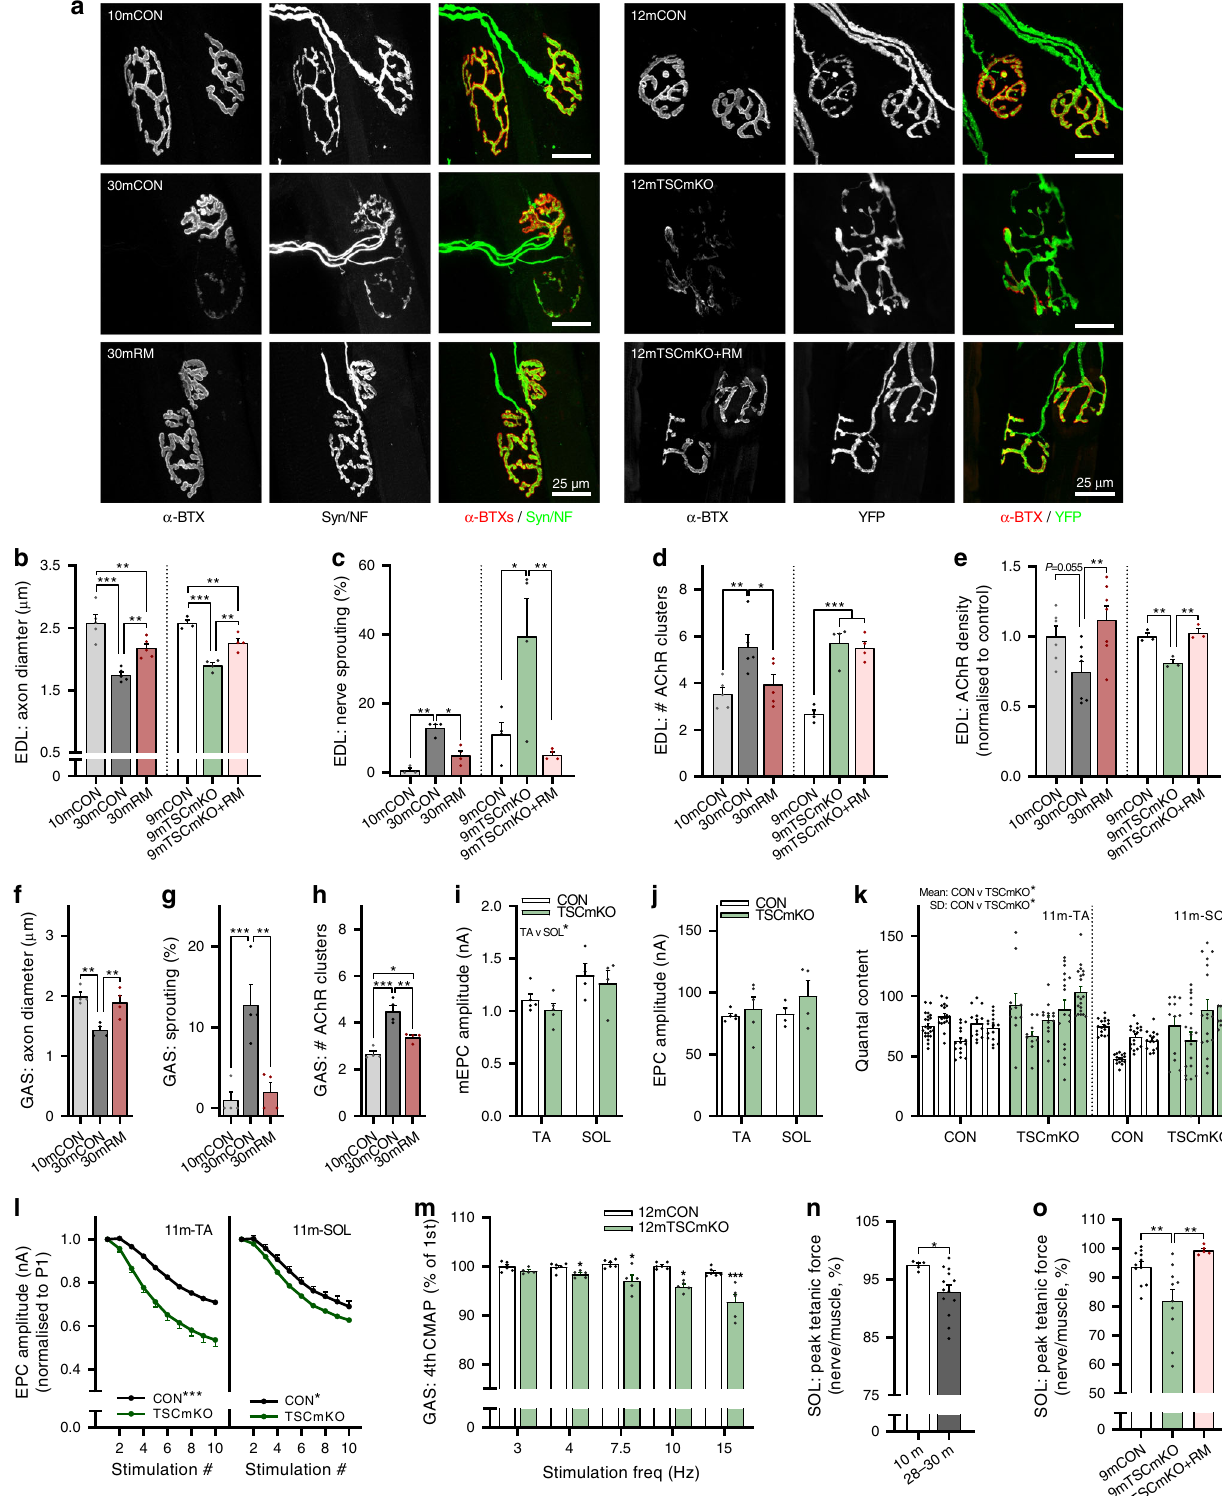
10mCON mice (Fig. 4a – d). Similarly, a 4-week treatment of TSCmKO mice with rapamycin normalized axon diameter and sprouting, but did not affect the number of AChR clusters (Fig. 4a – d). In line with previous reports 37,44 , we observed lower density of postsynaptic AChRs in cross sections from EDL muscles of 30mCON (trend) as well as 9mTSCmKO